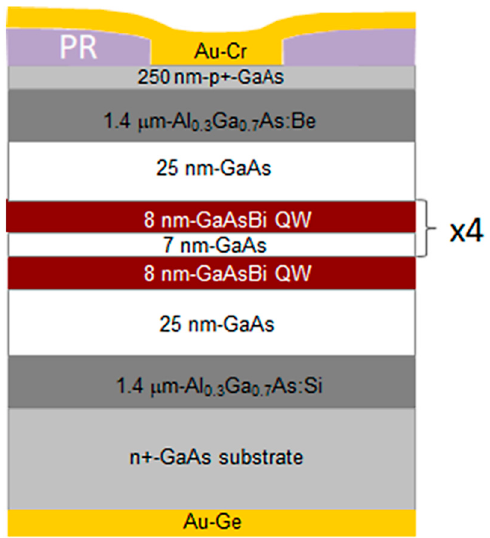
Figure 1. A schematic laser diode structure with 5 GaAsBi quantum wells (QWs).